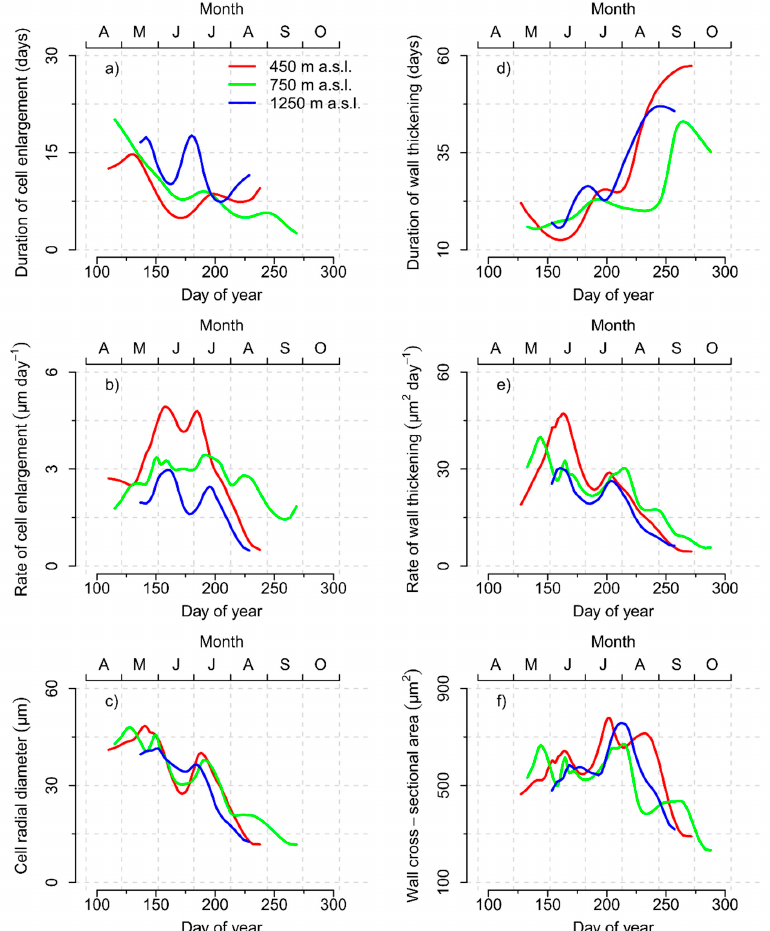
Figure 5. Seasonal variation of ( a ) the durations and ( b ) the rates of radial cell enlargement and ( c ) temporally annotated cell radial diameters. Seasonal variation of ( d ) the durations and ( e ) rates of wall thickening and ( f ) the temporally annotated cell wall cross-sectional areas for the 450 m, 750 m, and 1250 m a.s.l. elevation sites, respectively. Temporal annotation was conducted by calculating the average day of year (DOY) of enlargement ( c ) or average DOY of wall thickening ( f ) for each cell.